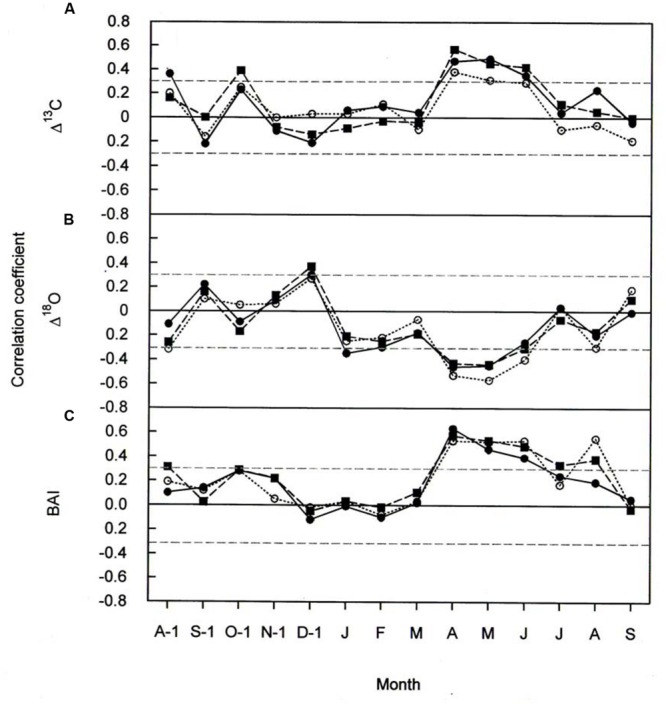
Pearson correlation coefficients between (A)Δ13C(B)Δ18O, and (C) BAI, and monthly mean temperature for P. cembra (solid circle, solid line), P. abies (solid square, dashed line) and L. decidua (open circle, dotted line) between 1975 and 2010. Horizontal gray lines indicates P < 0.05.